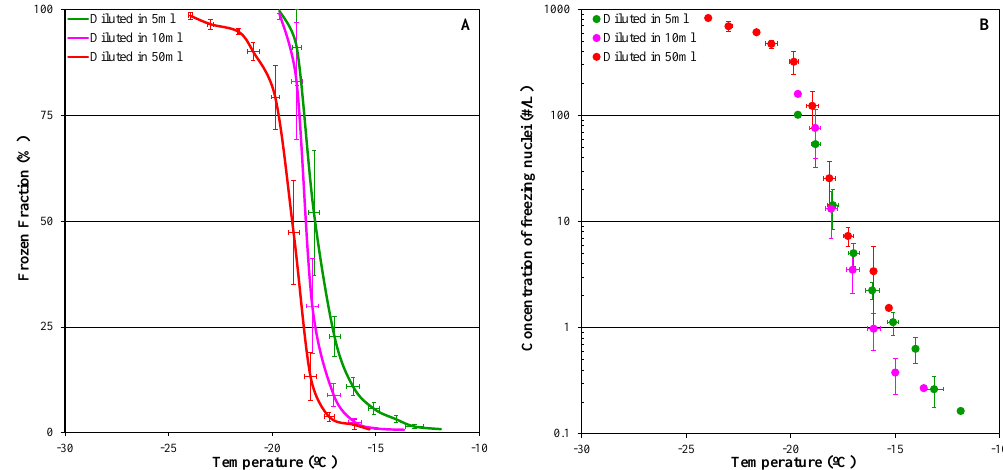
Figure 2. Results of freezing experiments using montmorillonite particles. (A) Cumulative frozen fraction as a function of temperature of all three dilution experiments. (B) FN concentration calculated as a function of temperature for the different dilution